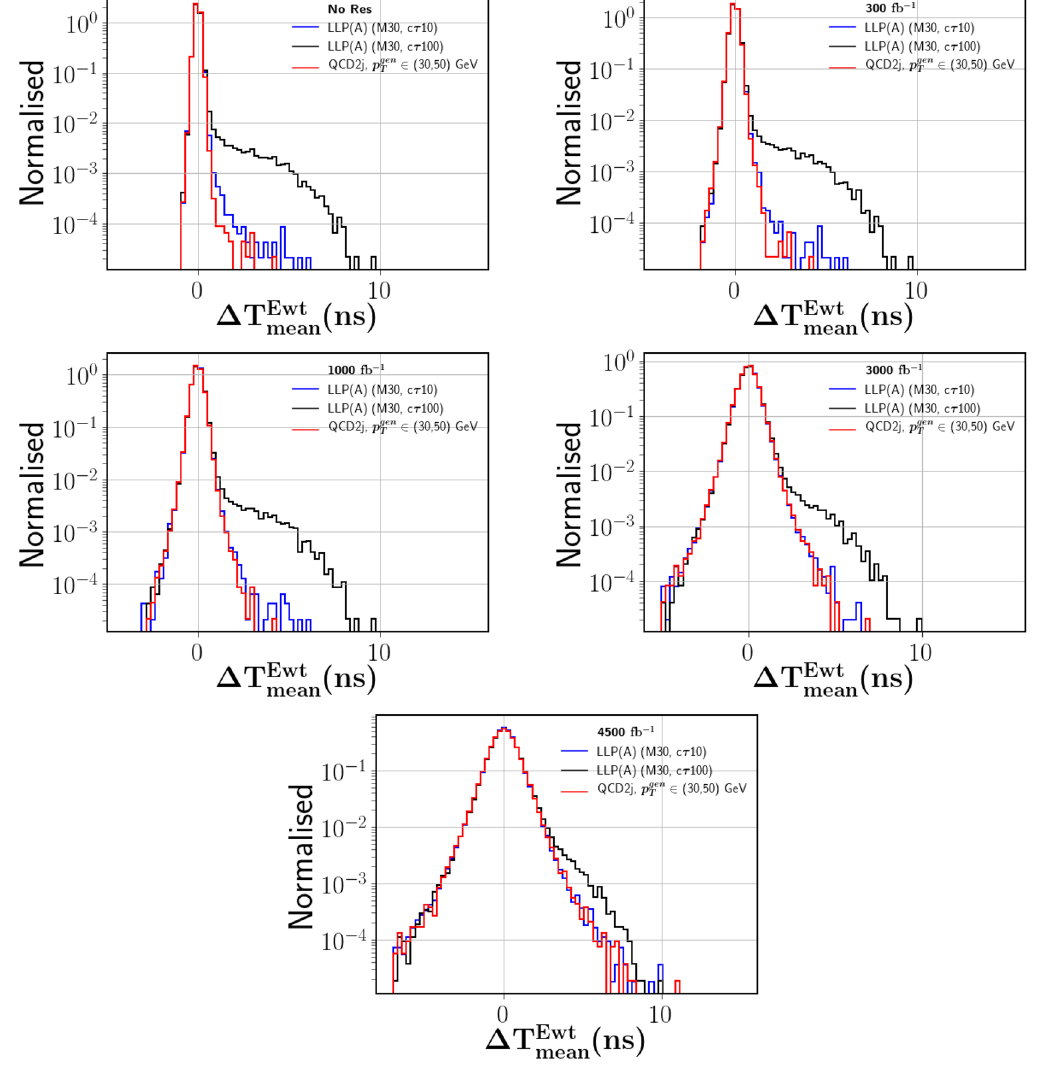
) of the jets for LLP (A) benchmark ( M mean = {30,50} GeV) with R = 0 . 3 cone radius without any T